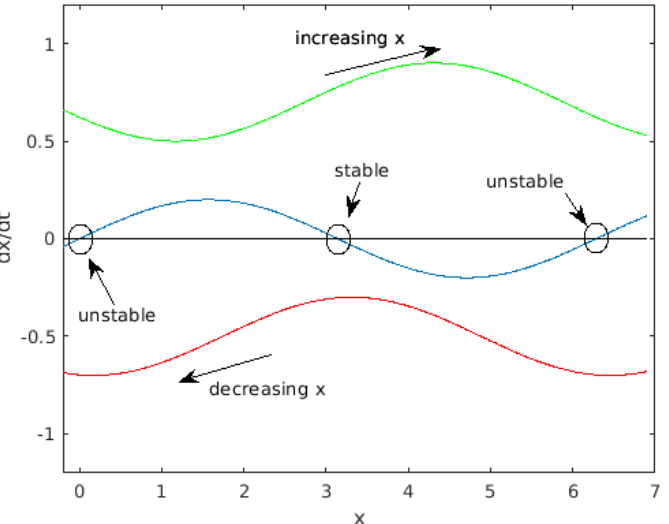
Figure 1. Example of an arbitrary typical DRM. The three curves correspond to three different situations: the blue line presents three intersection points with zero, thus showing that the system, for that case, has two unstable and a stable points. The red line shows a case where the variable x is always decreasing, while the green line shows the opposite case where x is always